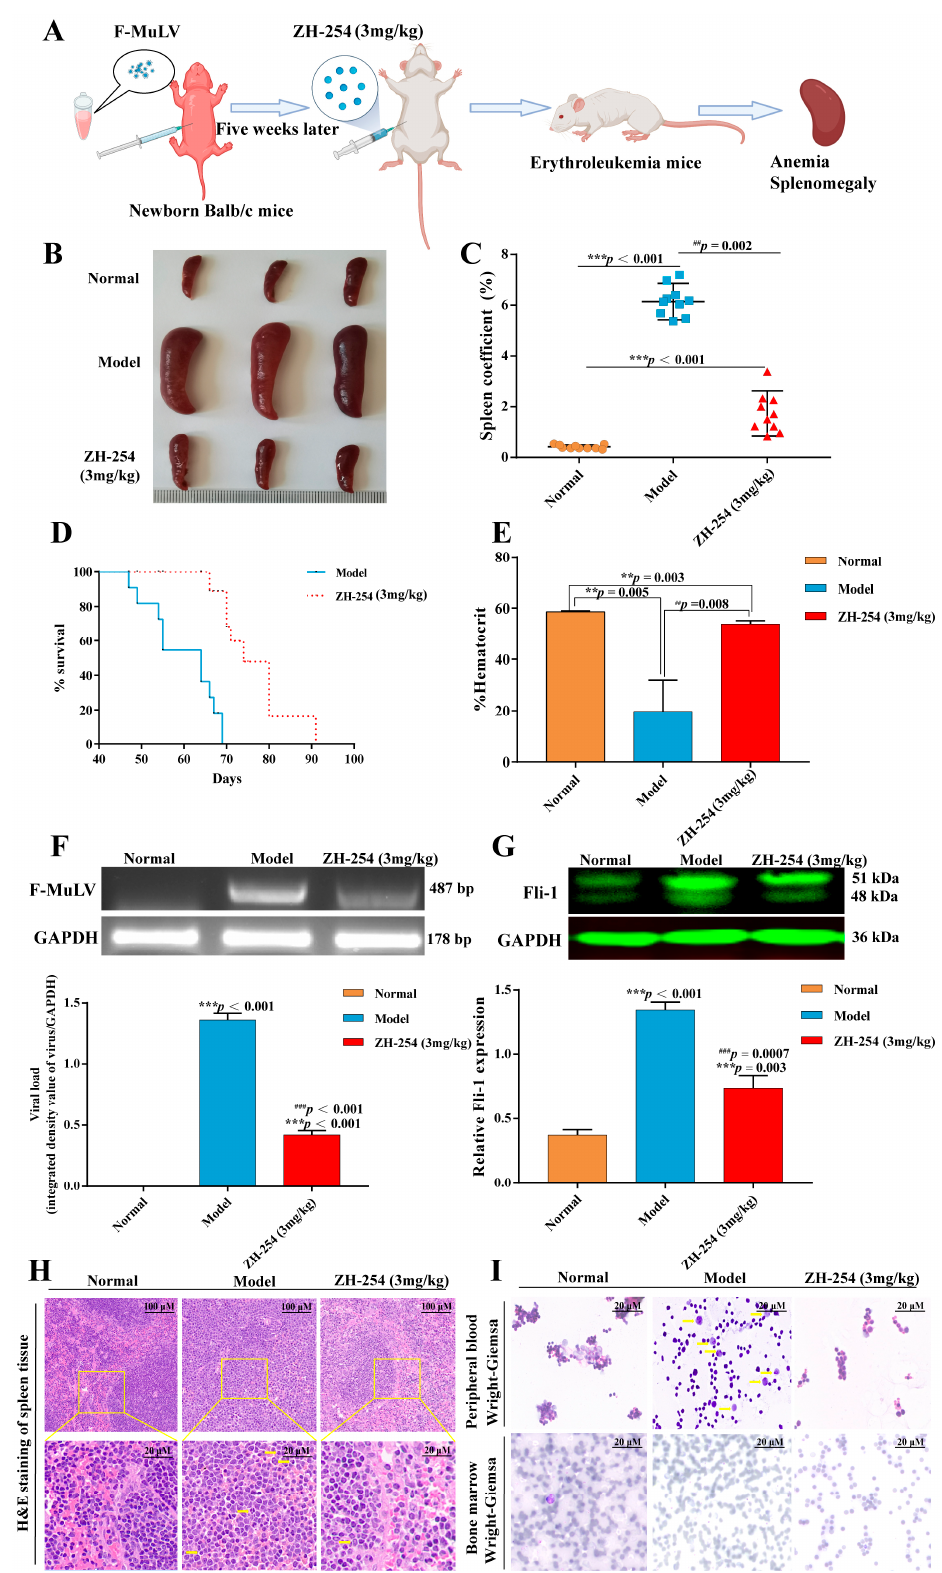
Figure 2. Compound ZH-254 inhibits leukemogenesis in F-MuLV-induced erythroleukemia. ( A ) A schematic diagram of the modeling process of erythroleukemia mice. ( B ) Illustration of splenomegaly and statistical chart of splenic coefficients ( C ). ( D ) Kaplan–Meier survival curves for each experimental group ( E ) Statistics of the hematocrit rate of these leukemic mice. ( F ) Effect of ZH-254 on splenic